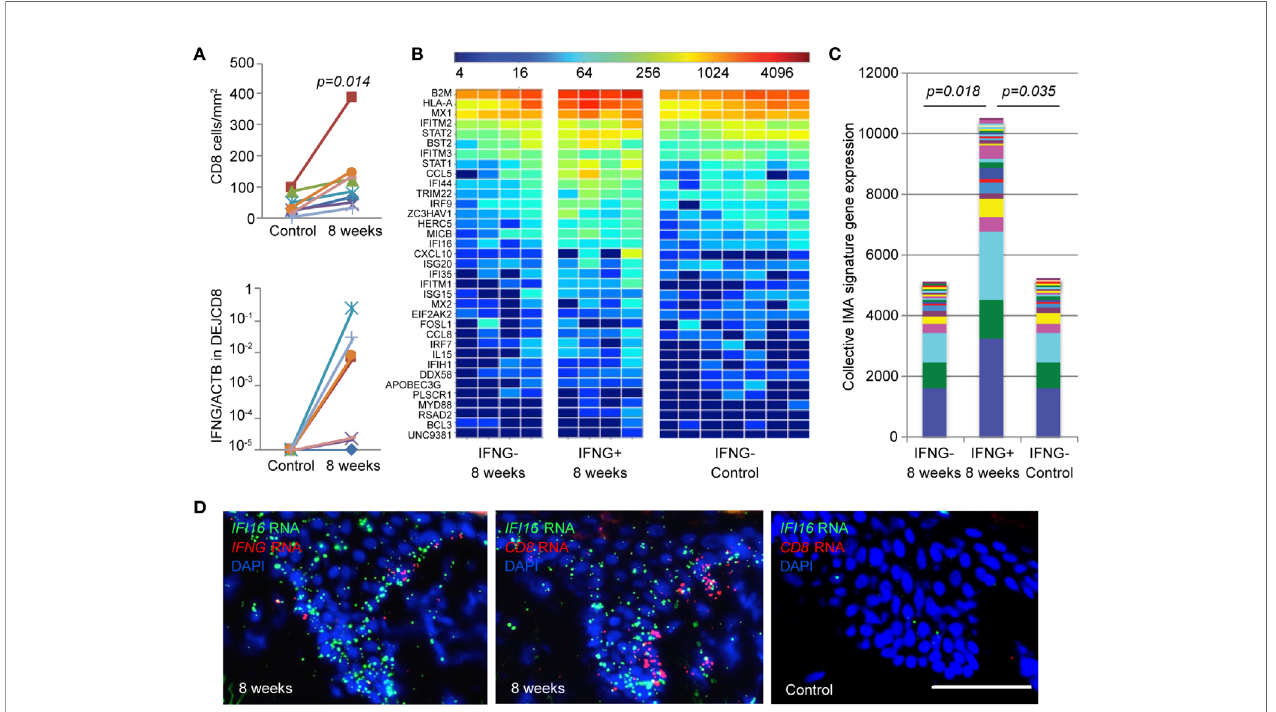
FIGURE 5 | Elevated level of IMA gene signature expression correlates with IFNG expression by DEJ CD8TRM cells in HSV-2 post-healing human skin. (A) Cell density (upper) and IFNG gene expression (lower) of DEJ CD8TRM in skin biopsies taken at the sites of 8-week post-healing and their matched contralateral controls (n = 8). DEJ CD8TRM cells were laser microdissected and coupled with quantitative RT-PCR. IFNG gene expression relative to ACTB. Individual (B) and collective levels (C) of IMA gene signature expression in the 8-week and control set of skin biopsies with or without IFNG detection. (D) Micrographic images depicting spatial expression of IFI16 , CD8 and IFNG mRNA transcripts in skin epidermis using RNA FISH dual probe sets of IFI16 + IFNG or IFI16 + CD8 in adjacent tissue sections of an 8-week skin biopsy, and dual probe set for IFI16 + CD8 on matched normal control skin. Scale bar, 100